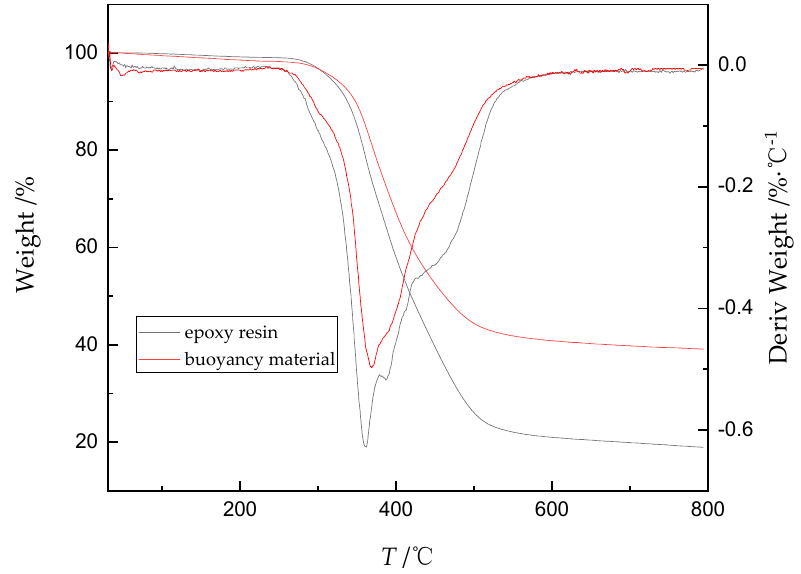
Figure 9. TGA thermographs of cured AG-80 / m-XDA ( phr = 26) and AG-80 epoxy resin-based buoyancy material ( V H = 55%) with heating rate of 10 ◦ C / min in N 2